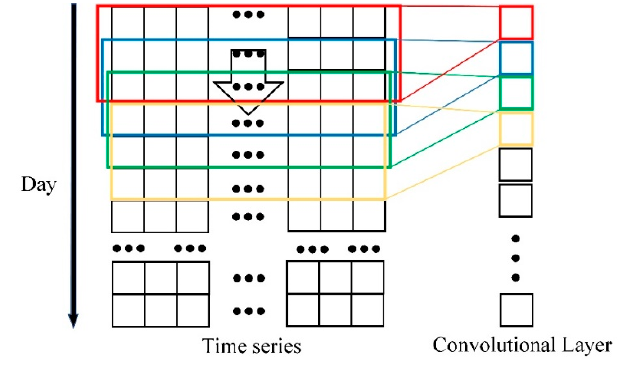
Figure 7. Principle of the candlestick chart sample generator.